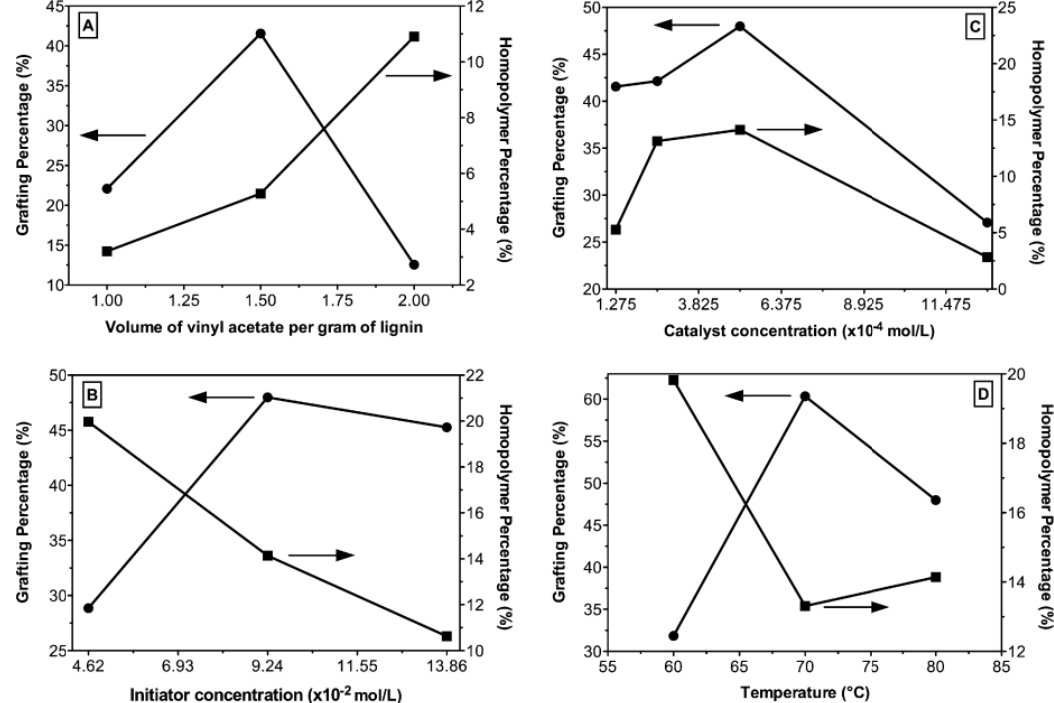
Figure 9. Effect of reaction conditions on graft copolymerization. Reproduced from [100], with the permission of Elsevier. ( A ) The effect of monomer concentration on grafting percentage and homopolymer formation, ( B ) The amount of potassium persulfate used in the reaction medium in the graft copolymer formation, ( C ) The effect of catalyst concentration on grafting percentage and homopolymer formation, ( D ) The temperature influence on grafting percentage and homopolymer formation.